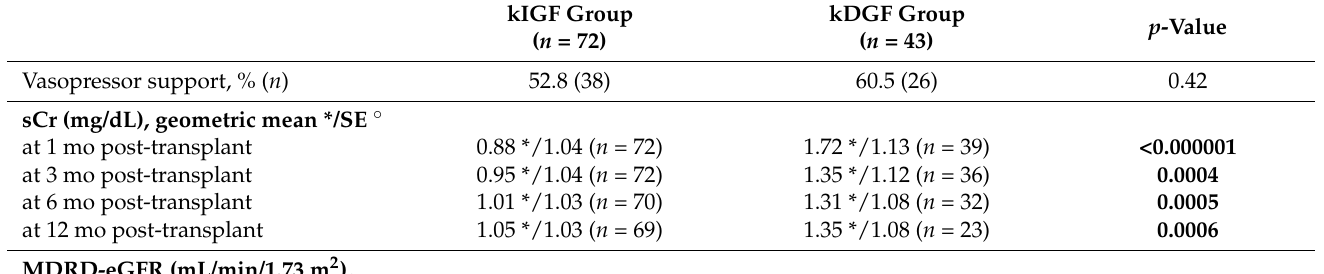
Table 4. Comparisons of postoperative outcomes by group (kIGF vs. kDGF) 1